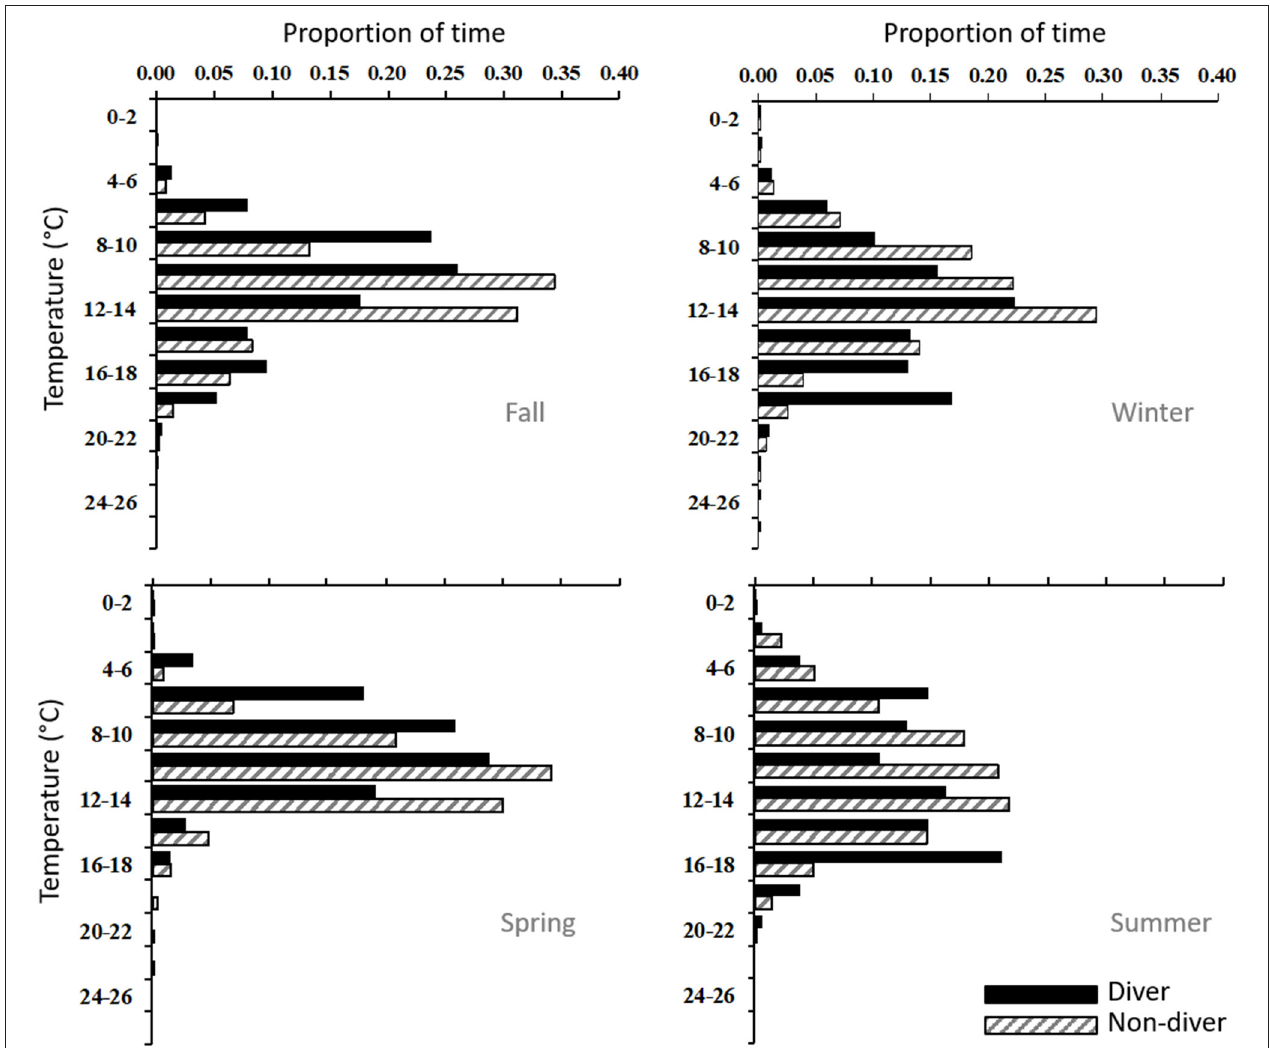
FIGURE 7 | Seasonal time-at-temperature histograms for porbeagle divers (solid bar; n = 10) and non-divers (hatched bar, n = 7) tagged in the western North Atlantic.